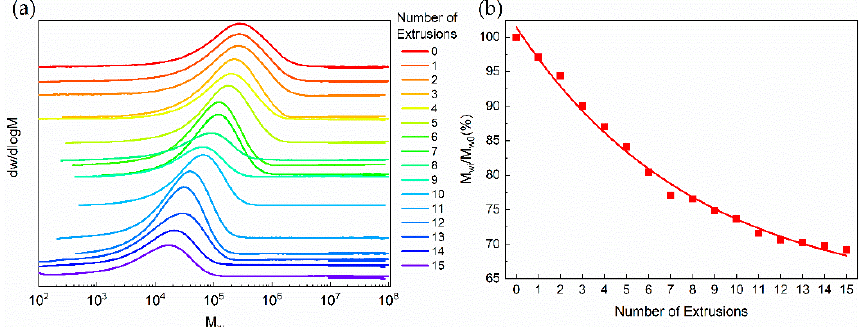
Figure 4. Results of GPC in PP with di ff erent numbers of extrusions. ( a ) Variation of Molecular weight distribution curve, ( b ) variation of M wi / M w0 . M Wi is the weight average molecular weight of the i-th extrusion.